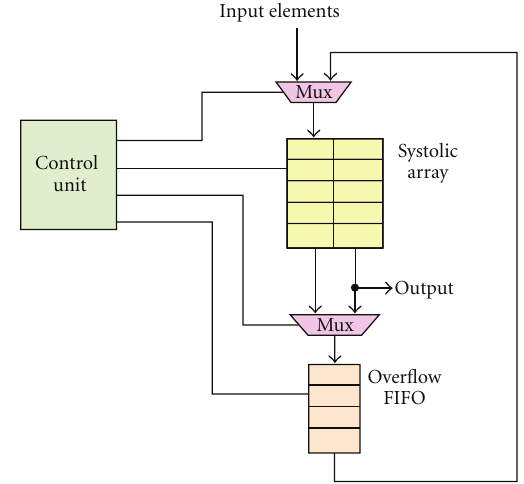
Figure 4: Pipeline with added overflow FIFO and control unit to support sequences longer than n .